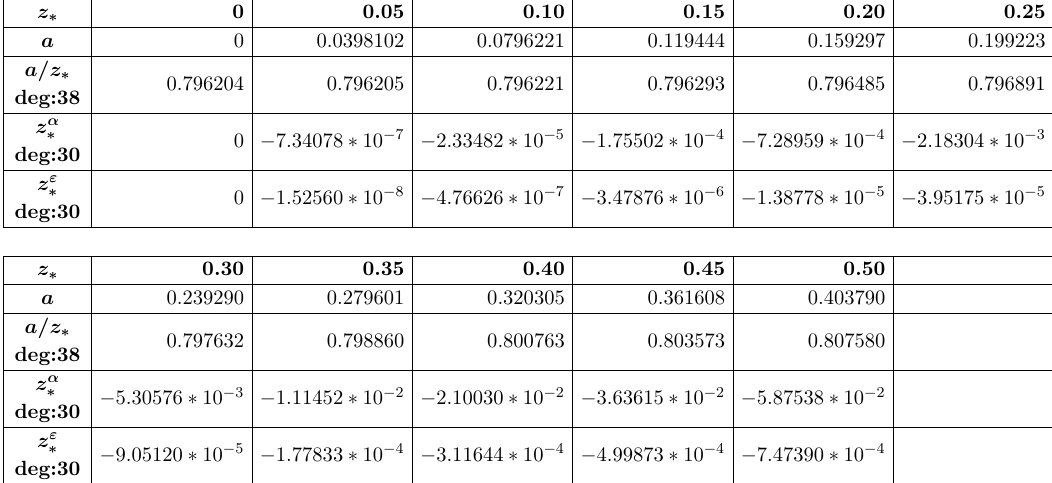
(the α 2 correction ∗ ) with given ∗